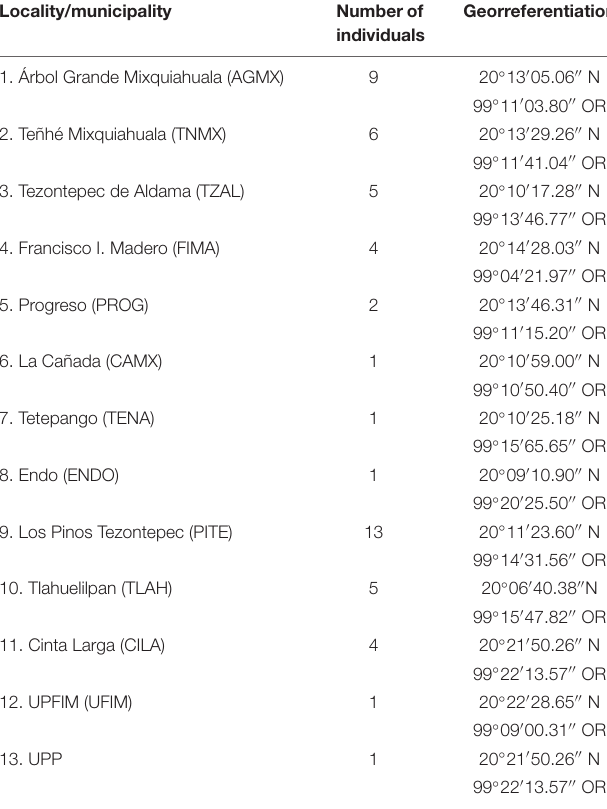
TABLE 1 | Geographic distribution of the samples of S . reilianum